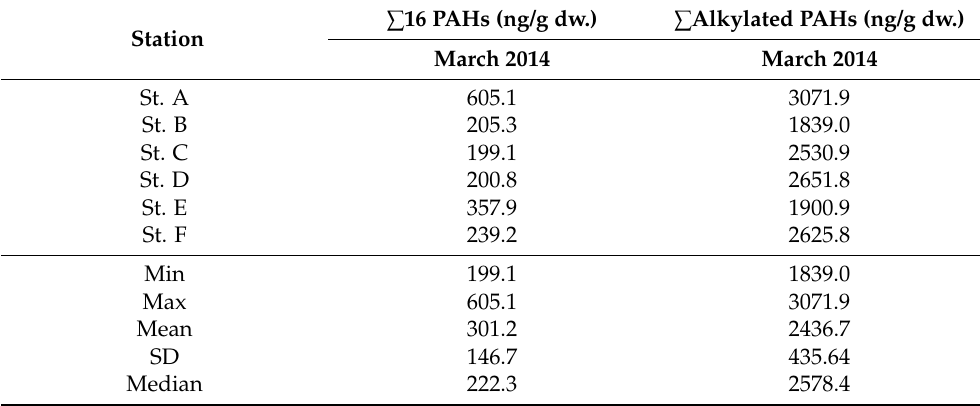
Table 3. Total concentration of 16 PAHs and alkylated PAHs in subtidal sediments at the Wu Yi San oil spill